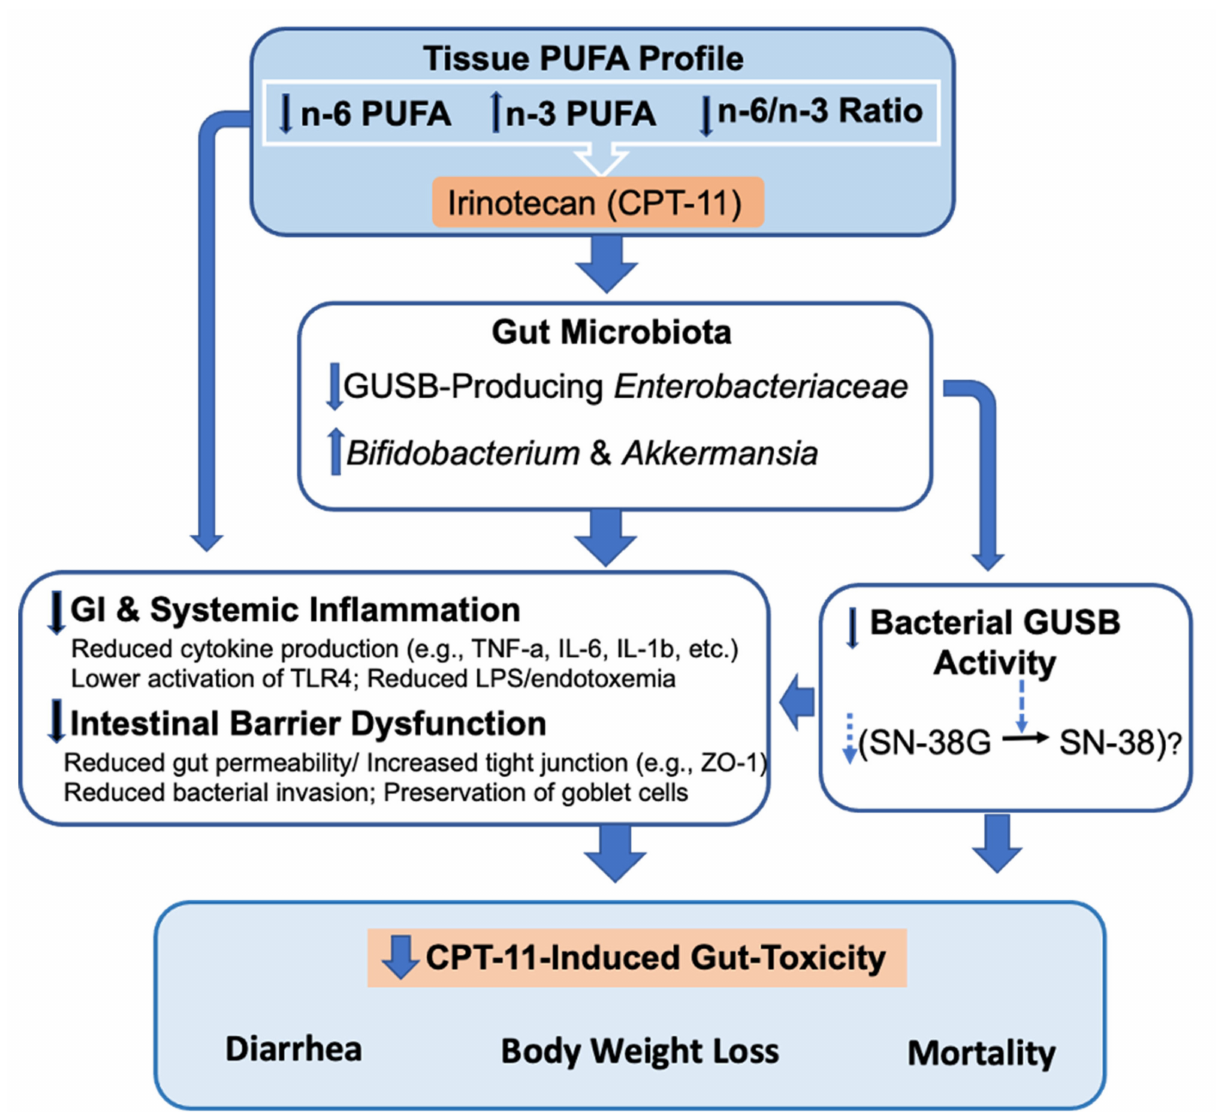
Figure 8. Proposed mechanisms for the preventive effects of the decreased tissue n-6/n-3 ratio on the CPT-11-induced gut toxicities. Diagram illustrating that elevated tissue omega-3 PUFA status with a reduced tissue n-6/n-3 PUFA ratio alters gut microbiome composition and functions, exerts anti-inflammatory and mucosal protective effects, and additionally, reduces the abundance of GUSB-producing bacteria, GUSB activity and potentially the conversion of inactive SN-38G to toxic SN-38. These alterations together with other gut-microbiota-independent mechanisms reduce mucosal injuries, mucosal inflammation, goblet cell dysfunction, impairment in the gut barrier, and systemic endotoxemia, resulting in the prevention of CPT-11-induced gut toxicities (bodyweight loss, late-onset diarrhea, and bloody diarrhea, and